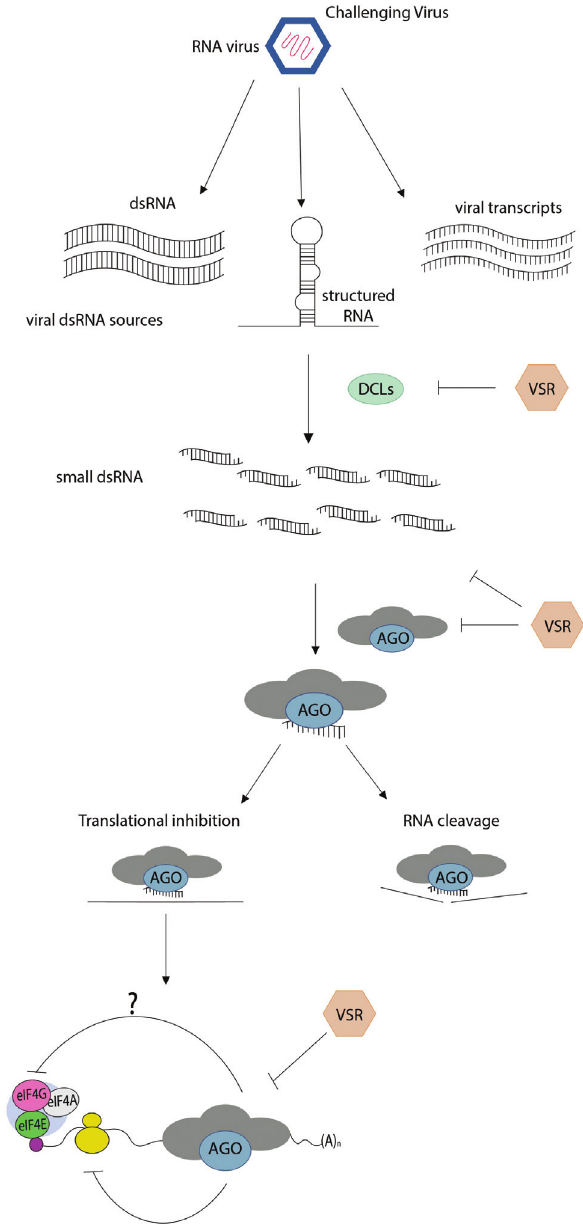
Figure 2 - An integrating overview of RNA silencing and AGO-mediated translational repression of mRNA targets. RNA silencing is launched by viral double-stranded RNAs (dsRNAs) from different sources, which are processed into small interfering RNA molecules of 21–24 nucleotide (nt) by Dicer-like (DCL) proteins. Subsequently one strand of the siRNA du- plexes is loaded into RNA-induced silencing complexes (RISCs) harbor- ing an argonaute (AGO) effector protein. In light of post-transcriptional gene silencing (PTGS), AGO/sRNA complexes trigger viral RNA cleav- age or translational repression. Although unclear, translation repression directedbysRNAsinplantsseemstorelyonAGOactivity,whichmayact targeting ribosome assembly, interfering with 48S initiation complex for- mation, or translational initiation factors (eIFs). The AGO-RISC complex is further capable of repressing translation by preventing translation elon- gation or ribosomal recruitment. Viral suppressors of RNA silencing (VSRs) interfere in multiple steps of the antiviral RNA silencing pathway, including dicing inhibition, viral RNA loading, AGO inactivation and suppression of its translational inhibitory